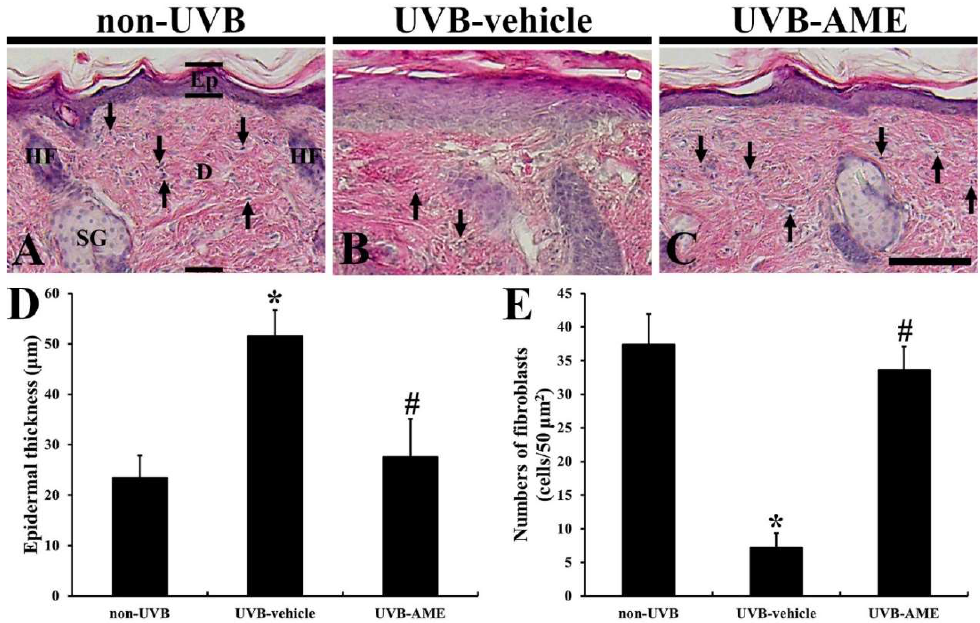
Figure 3. ( A – C ) Hematoxylin and eosin (H and E) staining in the dorsal skin of the non-UVB (A), UVB-vehicle (B) and UVB-AME (C) groups at 7 days after UVB irradiation. The epidermis (Ep) is thickened, and numbers of fibroblasts (arrows) are reduced in the non-UVB group. In the UVB-AME group, epidermal thickness and numbers of fibroblasts are apparently recovered. D, dermis; HF, hair follicle; SG, sebaceous gland. Scale bar = 50 μm. ( D and E ) Mean epidermal thickness (D) and mean numbers of fibroblasts (E) in the dorsal skin of the non-UVB, UVB-vehicle and UVB-AME groups at 7 days after UVB irradiation. Bars indicate the means ± SEM (n = 10 in each group, * p < 0.05 vs. non-UVE group, # p < 0.05 vs. UVB-vehicle group).